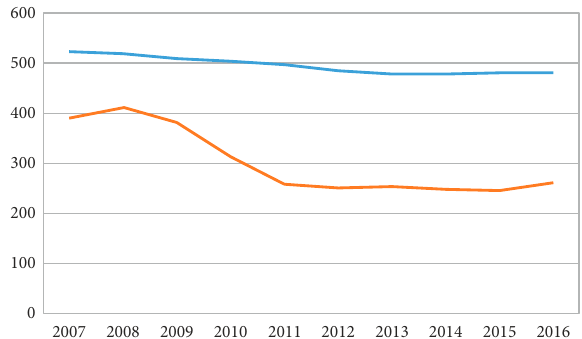
Figure 4. The evolution of municipal waste generated per capita in Romania, compared to the average in the European Union, during 2007–2016 (source: Own elaboration based on Eurostat